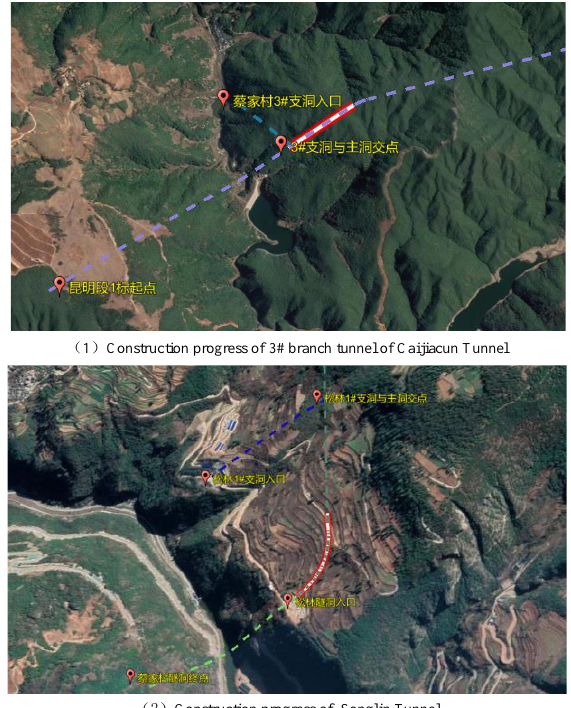
Figure 6. Branch tunnel construction progress